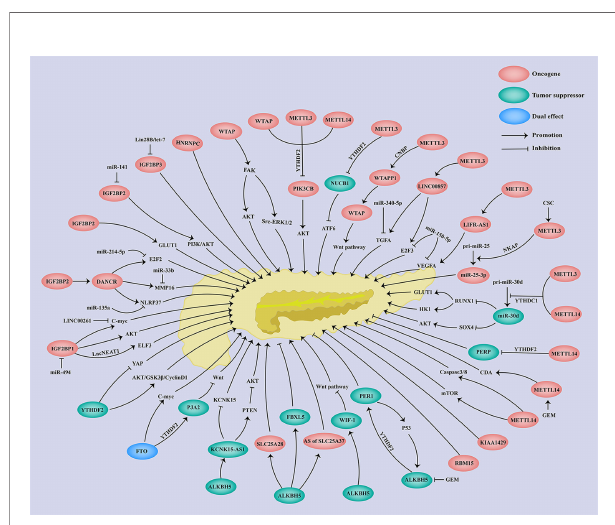
FIGURE 2 | Regulation network of m6A regulators and associated genes in pancreatic